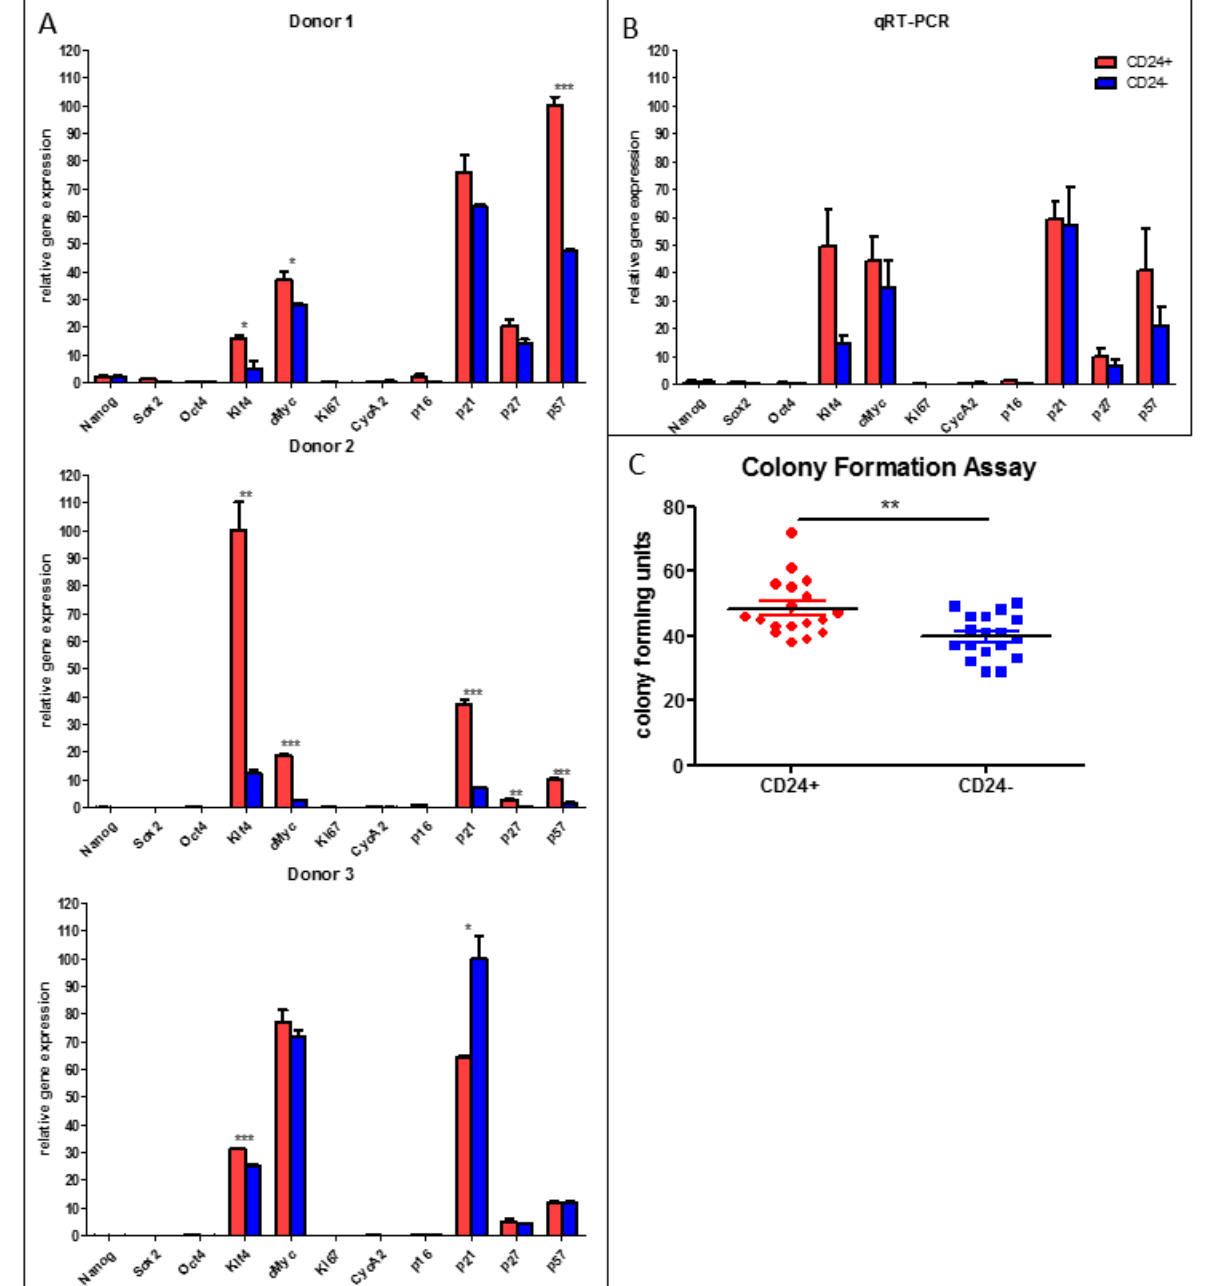
Figure 3. Analysis of the expression of markers for quiescence, proliferation, senescence, stemness and adipogenesis in DLK1 − /CD34 + /CD24 + and DLK1 − /CD34 + /CD24 − adipose stem/progenitor cells (ASCs). Cells were lyzed directly after sorting, RNA was isolated and RT-qPCR performed to analyze the mRNA expression of Cyclin A2, Ki67 (proliferation), p16 INK4a (senescence), p21 Cip1 , p27 Kip1 , p57 Kip2 (quiescence), NANOG, OCT4, SOX2 (pluripotency), KLF4 and c-MYC (stemness). ( A ) The gene expression in ASCs derived from three different donors is shown. ( B ) The results of the three donors are merged. Mean + SEM is shown, n = 3, gene expression normalized to RPS18, unpaired student´s t-test was performed to calculate significances. ( C ) Colony Formation Assay in CD24 + and CD24 − ASCs. 1000 cells per well were seeded in 6-well plates and colonies were counted 15 days post seeding; n = 18 from 3 donors, Mean + SEM is shown; unpaired student´s t-test was performed to calculate significances. * p < 0.05, ** p < 0.01 and *** p < 0.001.